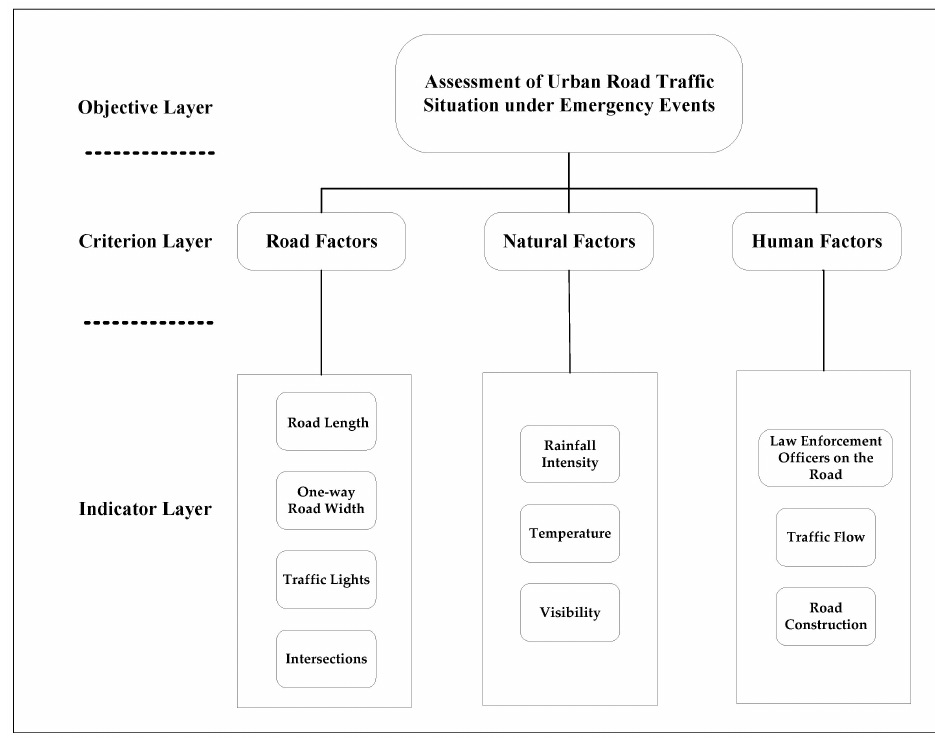
Figure 4. The hierarchical model for urban road traffic situation assessment during